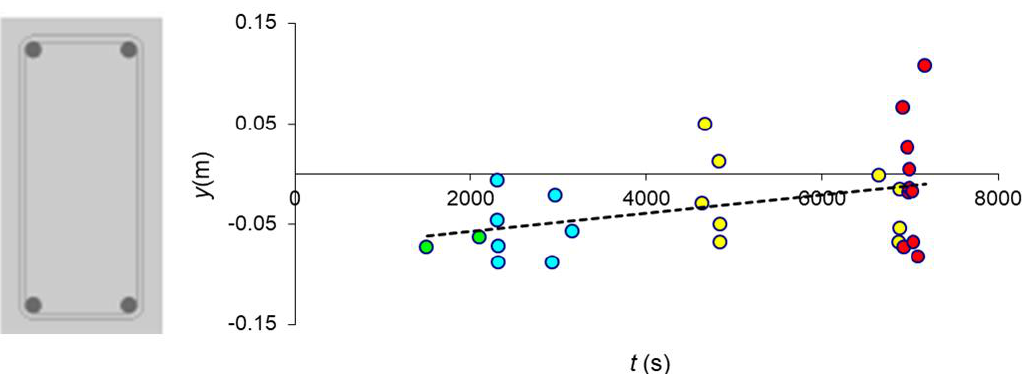
Figure 9. Height of localized AE events for different loading stages. Adopted reference system (x, y, z) as in Figure 1. Green color refers to load stages #1–#4, blue to #5 and #6, yellow to #7 and #8, and red to #9.